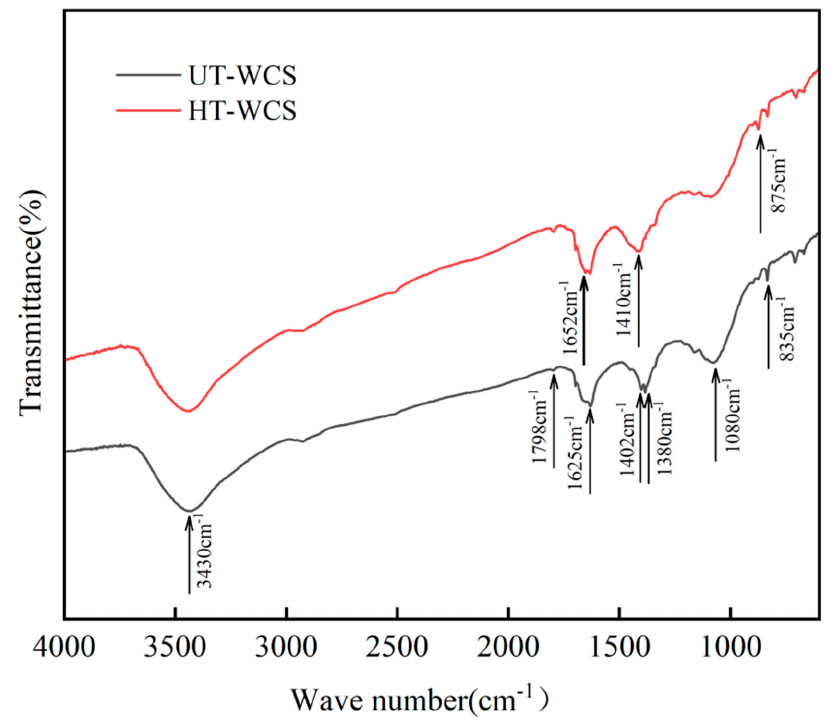
Figure 6. The FTIR spectra of WCS prepared from the different wood powders.